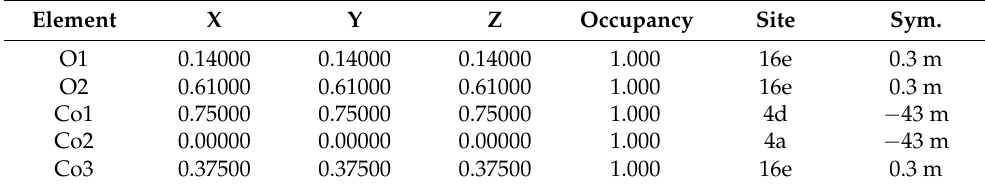
Table 2. Site occupancies of various ions along with their fractional